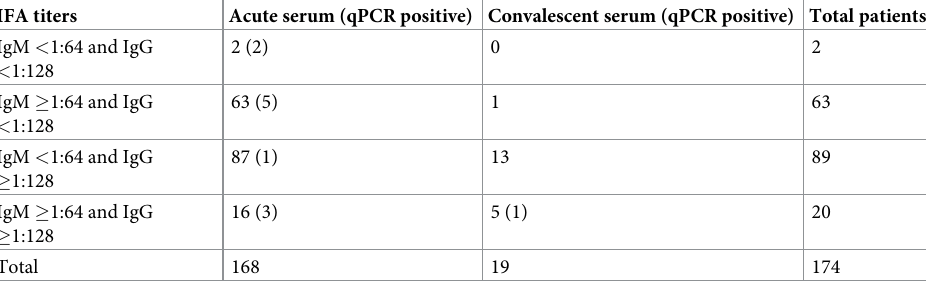
Table 2. IF assay antibody titers for the 174 confirmed murine typhus patients. IFA titers